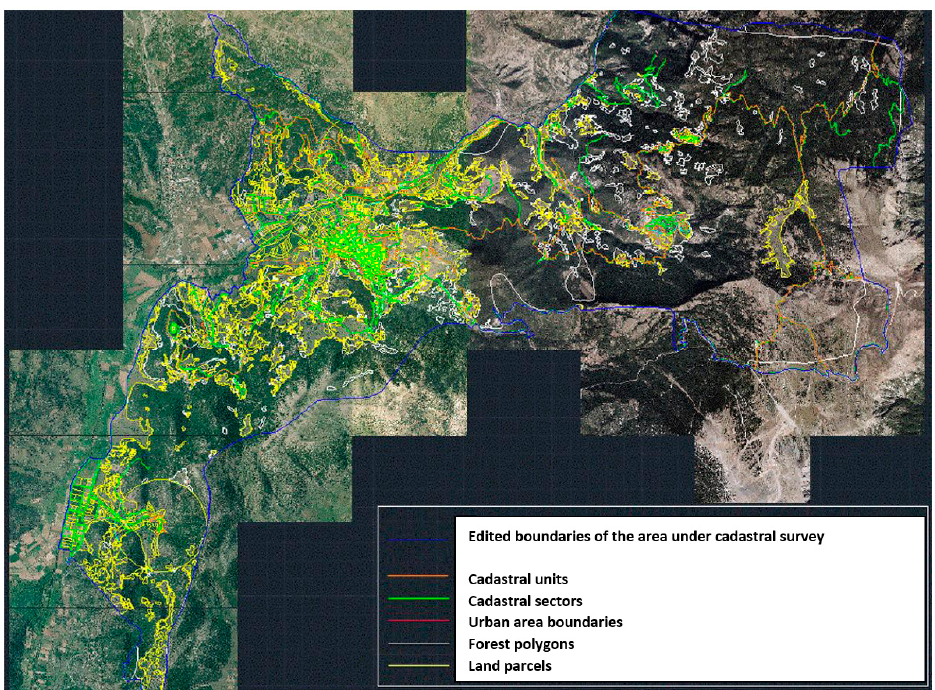
Figure 14. Example of an advanced basemap. Source: [35].